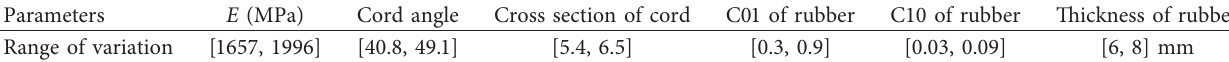
Table 2: Range of variation of interval variables for the air spring system.